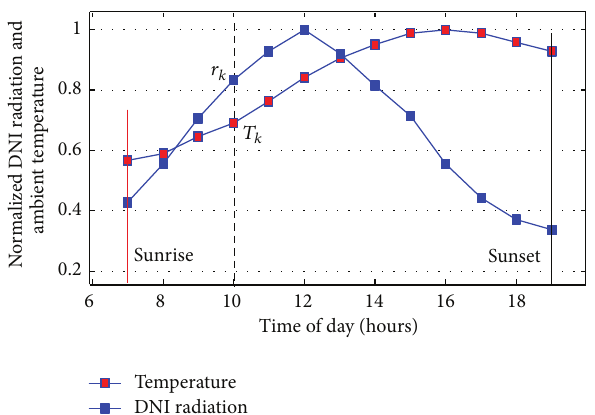
Figure 8: The normalized diurnal solar DNI radiation and ambient